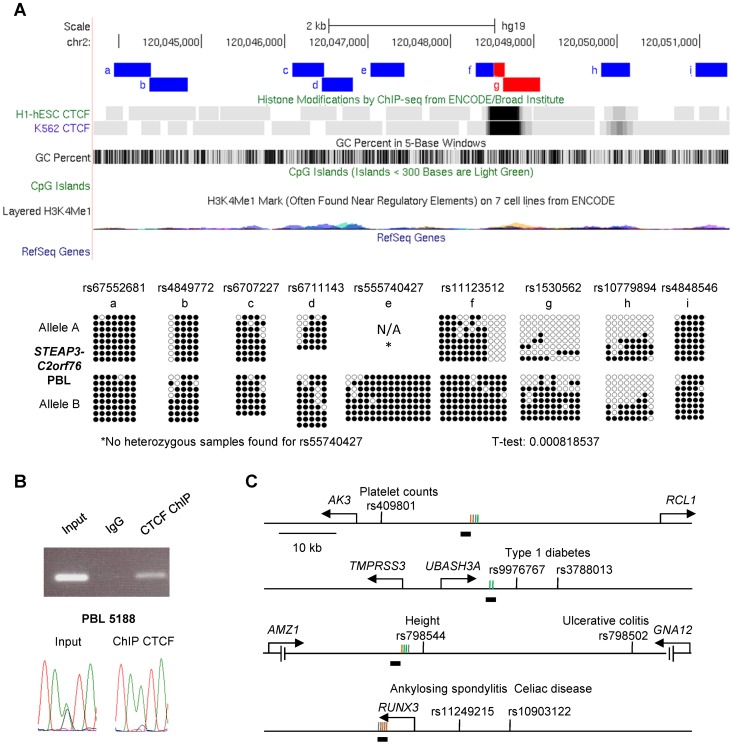
The STEAP3-C2orf76 DMR with non-imprinted ASM overlaps a CTCF site, with CTCF preferentially bound to the unmethylated allele, and cross-indexing of ASM-associated CTCF sites with GWAS peaks provides evidence for regulatory haplotypes.
A, Bis-seq of the STEAP3 - C2orf76 intergenic DMR in heterozygous PBL samples shows localization of ASM to a discrete region about 450 bp in length (chr2: 120,048,634–120,049,081) spanning the strong CTCF binding site. *No heterozygous samples were found for rs55740427. B, PCR of the STEAP3 - C2orf76 intergenic DMR performed on non-immunoprecipitated input DNA, negative control IgG IP DNA and CTCF ChIP DNA. As expected, the non-immunoprecipitated input sample results in a strong amplification while the negative control IgG IP sample shows no amplification. The observed amplification in the CTCF immunoprecipitated sample demonstrates CTCF binding at this region. Direct sequencing of end-point PCR products shows that the non-immunoprecipitated input DNA is heterozygous at the index SNP rs1530562 while the CTCF ChIP sample shows a strong enrichment for the A-allele indicating that CTCF is bound selectively to this (hypomethylated) allele. C, Maps of 4 representative haplotype blocks containing both a CTCF binding site with at least two ASM CpG sites (as defined by Chen et al. [15]) within a 1 kb window and SNPs associated with important human traits or disease susceptibility from GWAS (supra-threshold or strong sub-threshold peaks, all p<10−6; http://www.genome.gov/gwastudies). The relevant traits or diseases are indicated next to each SNP. The CpG sites that were analyzed for ASM (vertical lines) and located near the CTCF binding sites (horizontal black bars below the lines) are color-coded as orange for ASM sites that do not overlap with a CpG SNP, green for CpG SNP ASM sites, gray for non ASM sites. See also Table S4.